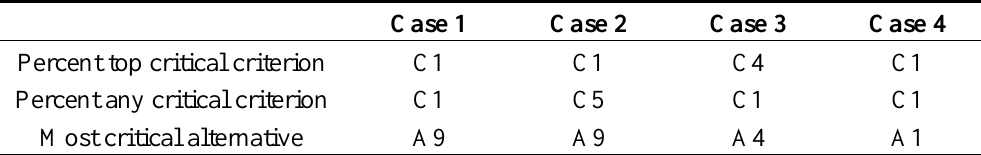
Table 6. Critical criteria and alternatives for each